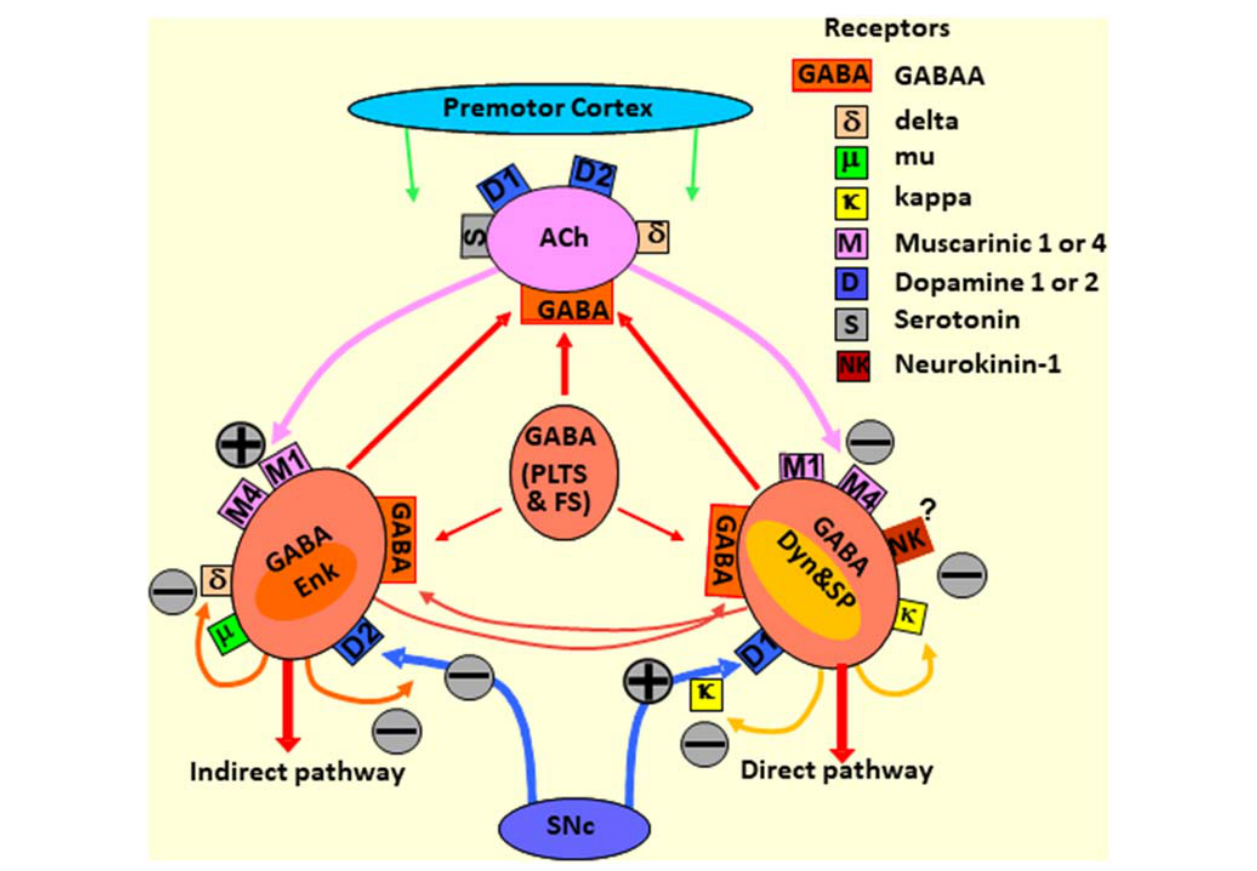
FIGURE 3 | Diagram depicting the striatal neurotransmitter systems modulating the responses of the striatal neurons to the premotor cortex and SN afferent signals. The direct and indirect pathways, as well as stimulating and inhibitory neurotransmitter receptors, are outlined. MSNs, medium spiny neurons; GABA, γ -aminobutyric acid; SNc, substantia nigra pars compacta; ACh, acetylcholine; Enk, enkephalin; Dyn, dynorphin; GABA (PLTS and FS), aspiny GABAergic interneurons, low-threshold spiking (PLTS) and fast-spiking (FS)